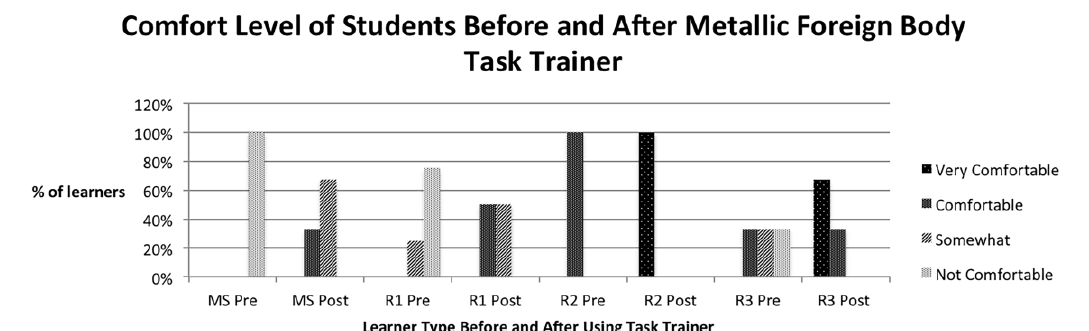
Figure 1. Level of comfort for medical students and residents year 1-3 before (pre) and after (post) the use of the metallic corneal foreign body task-trainer.